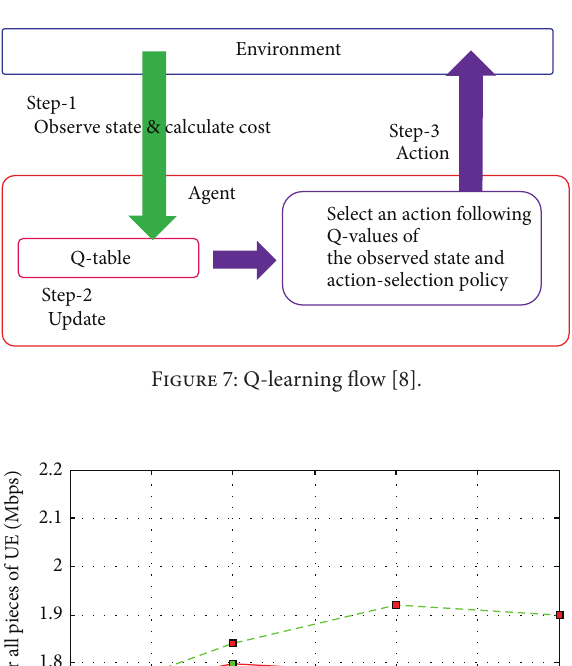
the offloading gain by decreasing loads from the MeNBs to the